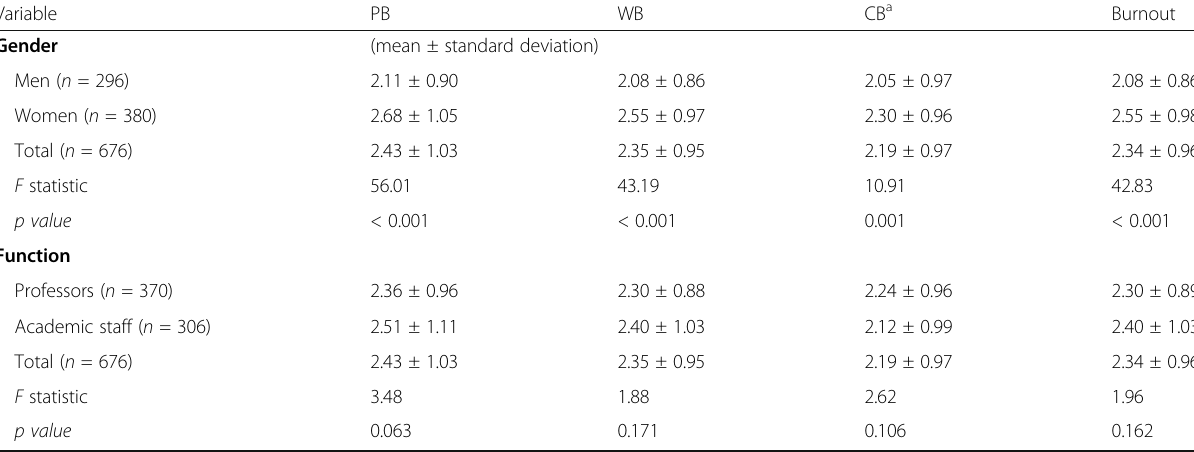
Table 2 The ANOVA of the overall weighted scores of CBI-Br (three-factor model) and the burnout (SOHM) between gender and function